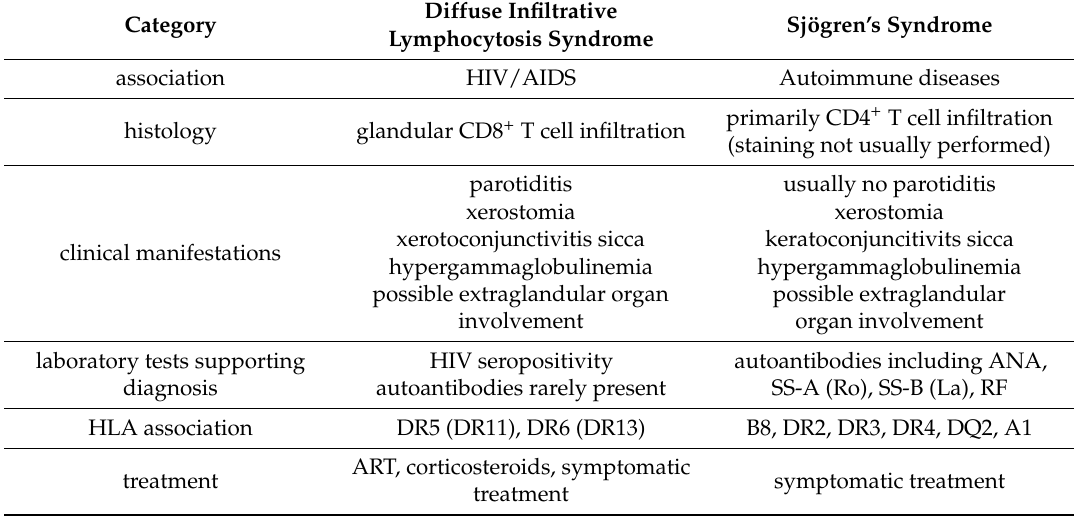
Table 4. Comparison of key characteristics of DILS (diffuse infiltrative lymphocytosis syndrome)